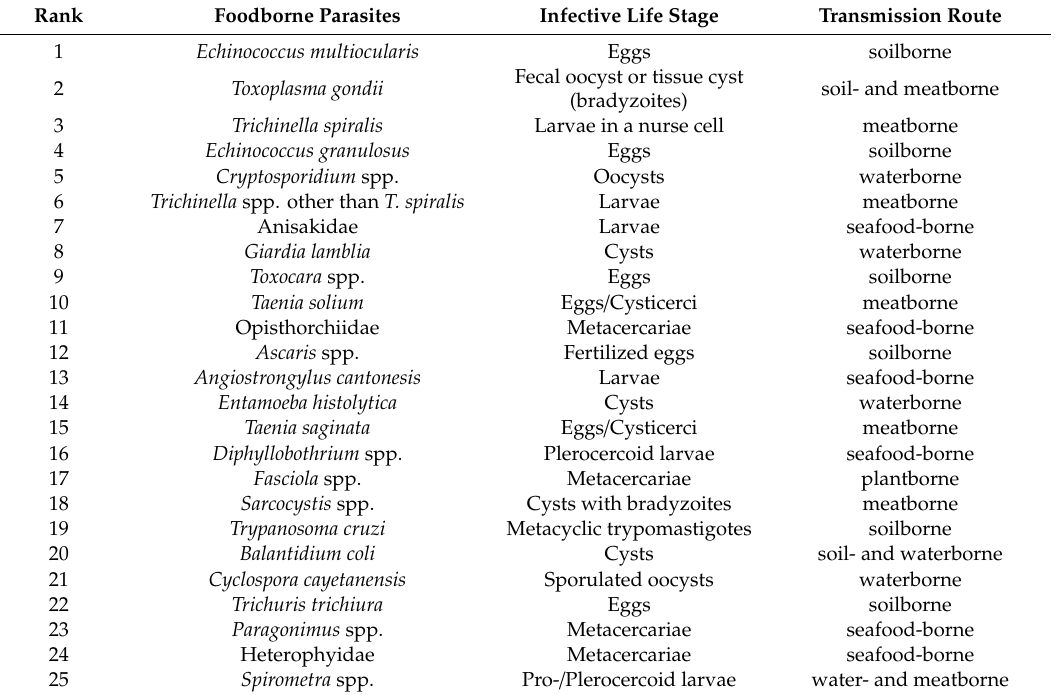
Table 1. Ranking of foodborne parasites in terms of their importance and risk for european countries accordingtothecriteriaoftheWorldHealthOrganization(WHO)andFoodandAgricultureOrganization of the United Nations (FAO). To see detailed multi-criteria decision analyses, see reference [36].